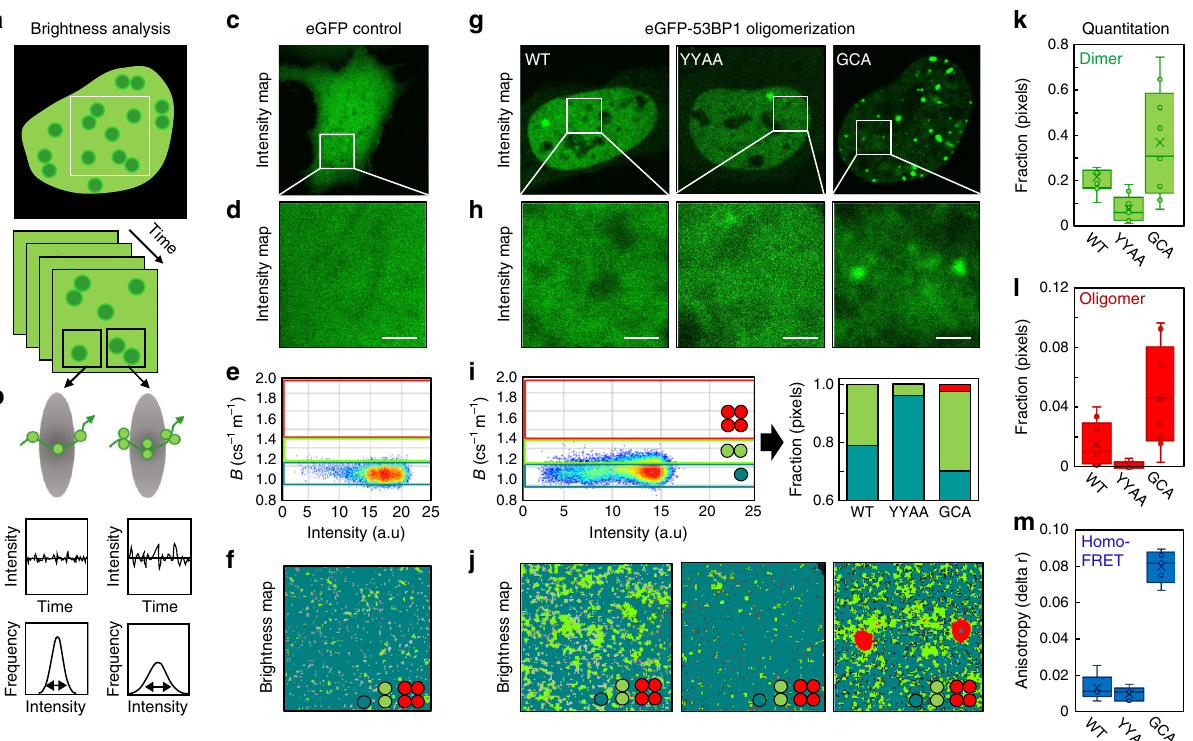
Fig. 1 NB analysis reveals 53BP1 to exist as a dimer throughout the nucleoplasm. a Schematic of a Number and brightness (NB) frame scan acquisition to measure eGFP-53BP1 oligomerization in a live DIvA cell. b Schematic of how eGFP-53BP1 monomer vs. oligomer diffusion through a diffraction limited point spread function of a frame scan pixel gives rise to a fl uorescence fl uctuation exhibiting a low vs. high variance with respect to the mean (de fi nition of apparent brightness and the parameter that reports the oligomeric state of eGFP-53BP1). c , d Intensity image of a DIvA cell expressing eGFP (monomer calibration) ( c ) and the region of interest (ROI) from which an NB data acquisition was recorded ( d ). e Intensity vs. brightness scatterplot of the NB data acquisition presented in d reports the monomeric brightness of eGFP and enables extrapolation of brightness windows to detect eGFP-53BP1 dimer and oligomer formation. f Brightness map of the eGFP NB data acquisition in d pseudo-colored according to the brightness windows de fi ned in e . g , h Intensity images of a DIvA cell expressing eGFP-53BP1 (WT), eGFP-53BP1 YY1258,1259AA (YYAA) and eGFP-GCA-53BP1(GCA) ( g ), and the ROI from which each NB data acquisition was recorded ( h ). i Intensity vs. brightness scatterplot of the eGFP-53BP1 NB data acquisition presented in h with the calibrated brightness windows superimposed (left) and quanti fi cation of the fractional contribution of 53BP1 monomer (teal), dimer (green), and oligomer (red) in WT vs. YYAA and GCA (right). j Brightness maps of the NB data acquisitions presented in h pseudo-colored according to the brightness windows de fi ned in i spatially map 53BP1 monomer (teal), dimer (green), and oligomer (red) localization in WT vs. YYAA and GCA. k , l NB quanti fi cation of the fraction of eGFP-53BP1 dimer ( k ) vs. oligomer ( l ) present in WT vs. YYAA and GCA across multiple cells ( N = 10 cells, two biological replicates). m Homo-FRET quanti fi cation of in k – m show the minimum, maximum, sample median, and fi rst vs. third quartiles. Scale bars, 2 μ